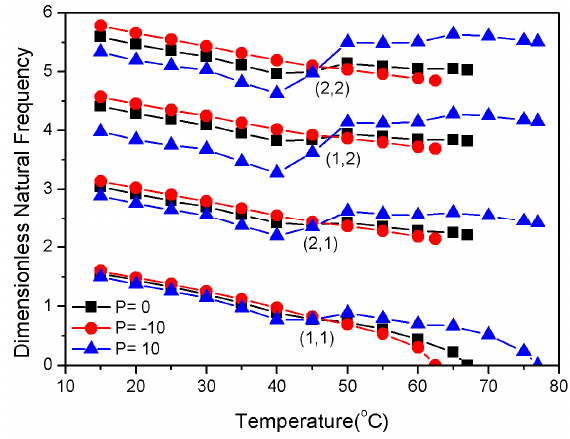
Figure 6. The lowest four order dimensionless natural frequencies.